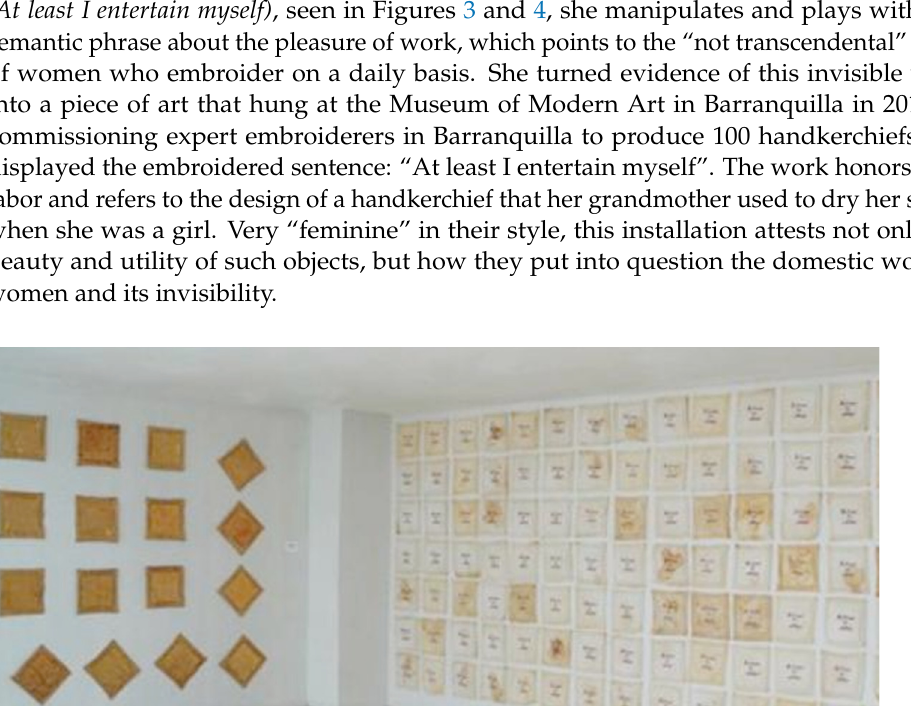
Figure 4. Jessica Sofía Mitrani, At least I Entertain Myself (2011). Image provided by the artist. These handkerchiefs are precious objects that pass as quotidian ordinary objects but that also remind us that in order to do such work, a lower-class woman must have finished all her other invisible work at home before having the time to embroider for pleasure. The questions about the immanence implicit in living as a woman in her assigned place are the same questions that a woman artist asks herself when producing a “transcendent” art piece. When these handkerchiefs move into the public square, in such a way, that is, by becoming something other than a handkerchief, an artwork, it is precisely by the transformation of everydayness into a particularity linked to transcendence. Mitrani seems to be saying: see me now, I am a woman, doing these things that are seen as entertainment while the males in my family do the serious work, but while I entertain myself, I use your mocking words in order to become an artist, but the women who did the actual work of embroidering the pieces that made possible the art piece are as invisible as any other housewife or factory worker, or secretary, nurse, or female artist. They drive the social machine, yet they are not heard or seen. They do not sign any of the embroidered pieces of cloth; the artist does. Jessica Sofía Mitrani, as artist, has transcended and broken the oikos model that she has inherited and jumped onto the public sphere with her artwork